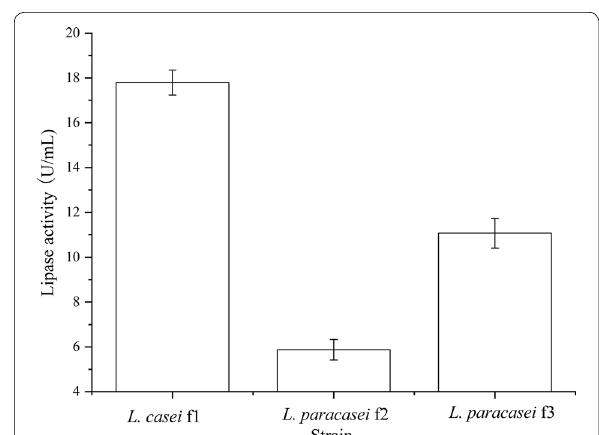
Fig. 3 Lipase activity of the isolated strains. Using the olive oil as the substrate, the lipase activity of L. casei f1, L. paracasei f2 and L. paracasei f3 were separately detected. Data are presented as mean SD (n 3). The vertical bar represents standard errors of ± =